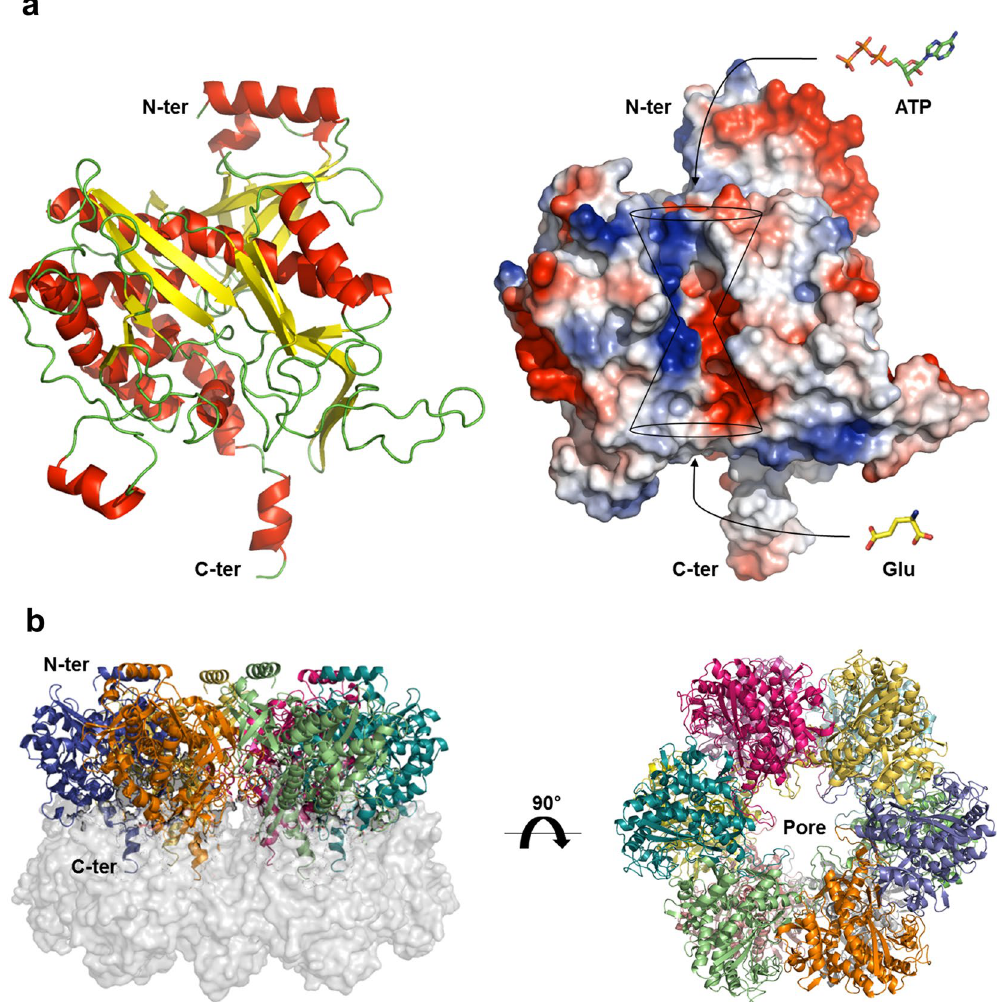
Figure 1. Overall structure of GS from H . pylori . ( a ) The monomeric structure of Hpy GS apo . Each active site has an entrance for ATP and glutamate. ( b ) Oligomeric structure of Hpy GS apo was generated by two-fold symmetry from hexamer in an asymmetric unit. The C-terminal helical thong of each subunit interacted with the C-terminal thong of opposite subunits. Twelve active sites were positioned at each subunit-subunit